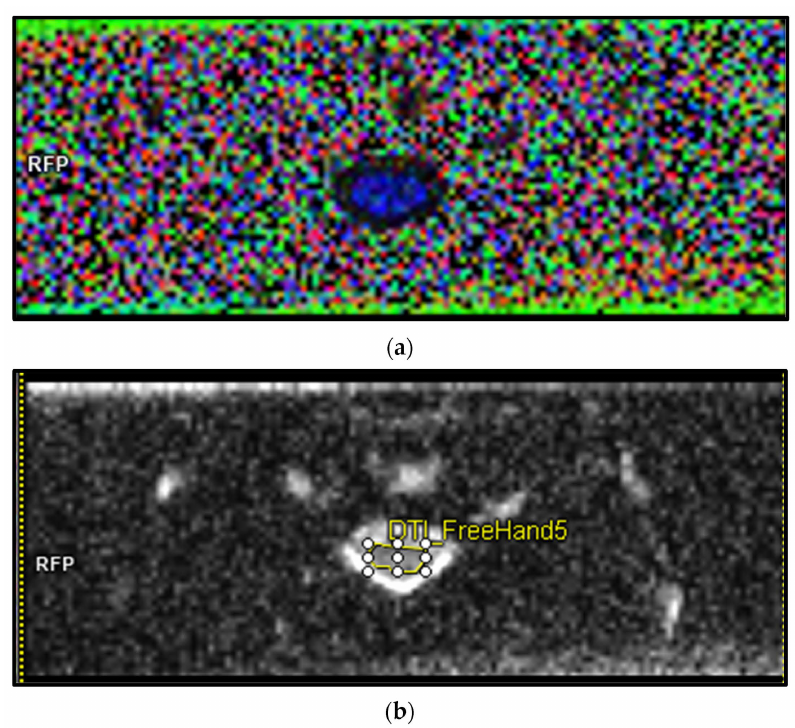
Figure 4. Preliminary data obtained from a healthy recruit using 3T MAGNETOM PRISMA MRI scanner with rFOV DTI ZOOMit sequence. From our standardisation work we have found rFOV to offer better visibility, better signal-to-noise, and less susceptibility and motion artifacts when compared to full field of view (fFOV) sequences. ( a ) axial Col-FA map of C4/5 cervical spinal-cord (red = left-right, blue = supra-inferior green = antero-posterior). ( b ) axial ADC map of C4/5 cervical spinal cord. Abbreviations: ADC, apparent diffusion coefficient; DTI, diffusion tensor imaging; Col-FA, colour fractional anisotropy; MRI, magnetic resonance imaging; rFOV, reduced field of view; ROI, region of